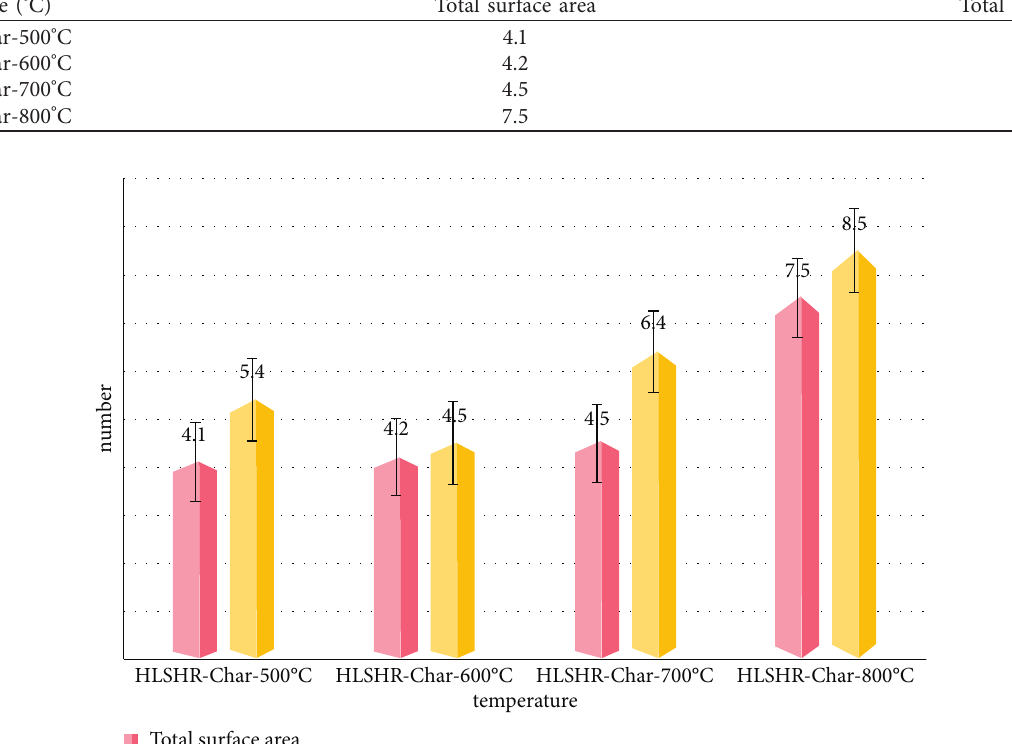
Figure 5: Total specific surface area and pore volume of copyrolysis semicoke.